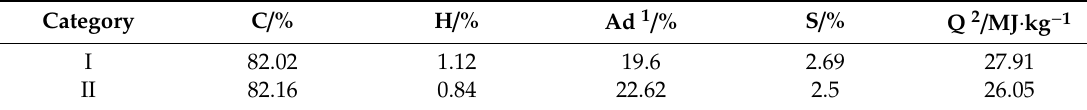
Table 5. Pyrolysis carbon black combustion properties.